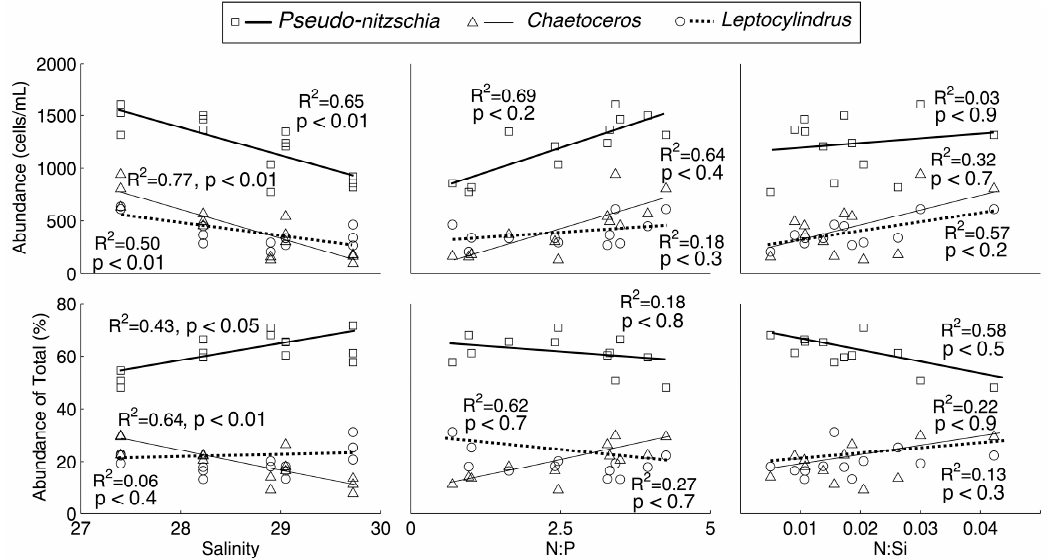
Figure 5. Total abundance and percent of total of Pseudo-nitzschia , Chaetoceros , and Leptocylindrus in the river water and groundwater treatment groups plotted against salinity, N : P , and N : Si , with significance of each slope.